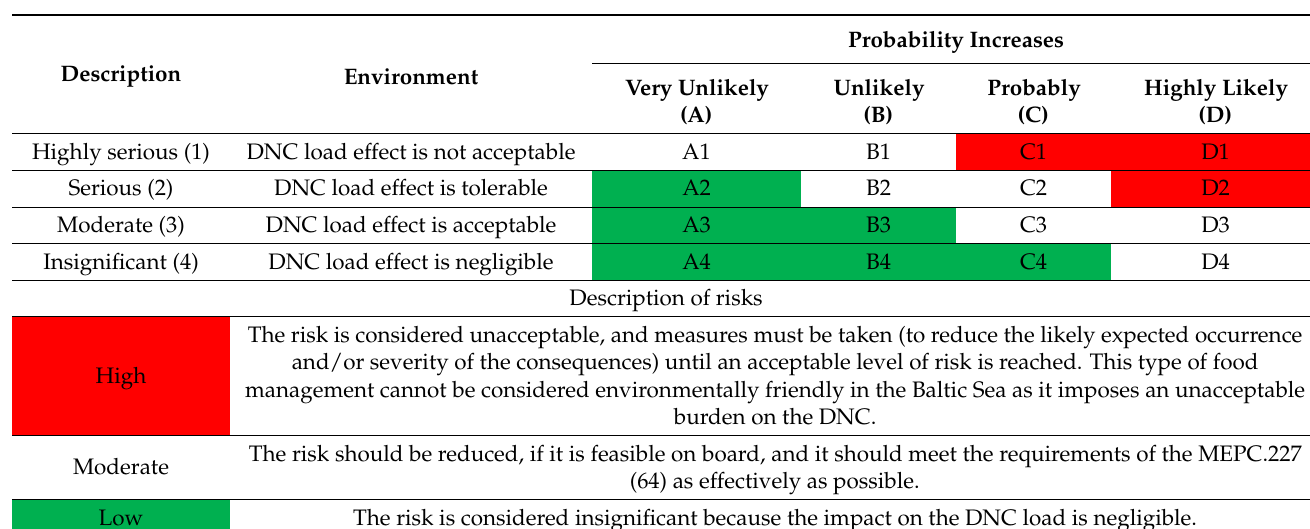
Table 6. DNC risk assessment matrix for food waste management in the Baltic Sea environment (adopted from [19]).